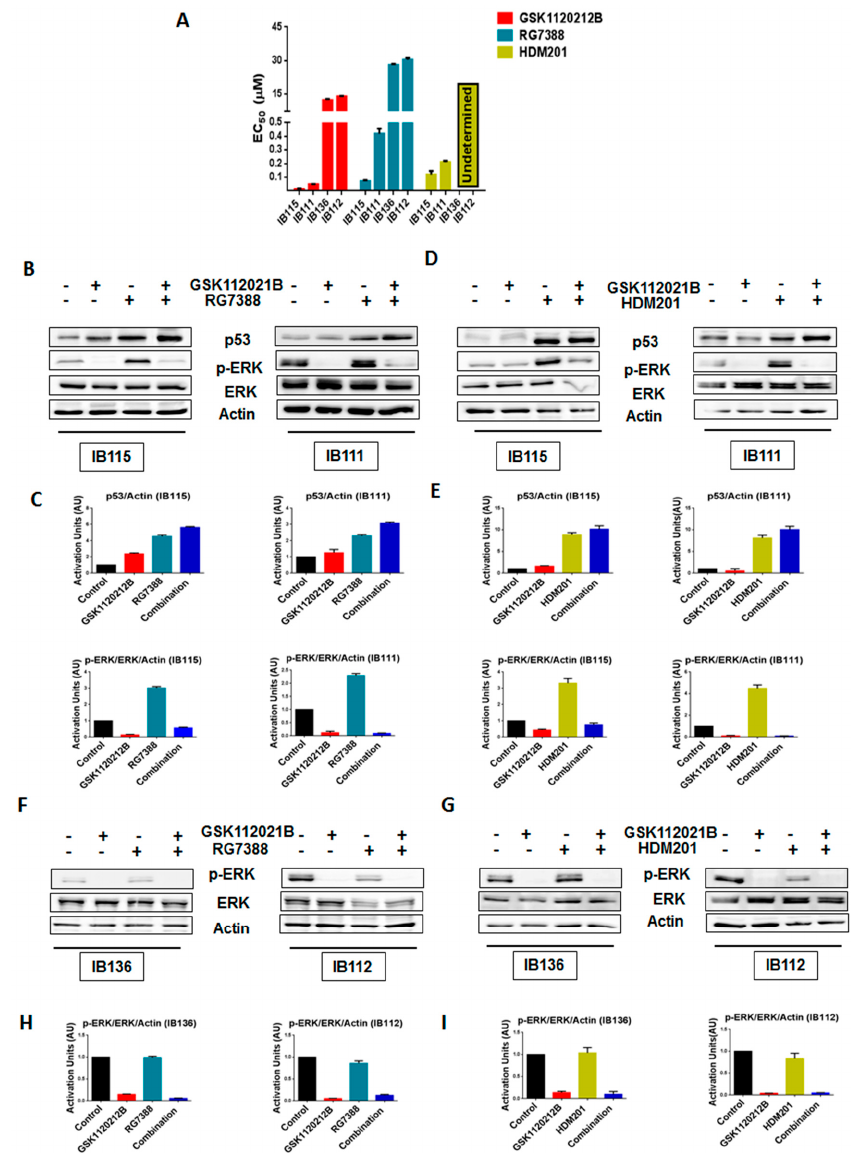
Figure 1. Significant upregulation of p-ERK by MDM2 antagonists is observed in p53 wild-type cells. ( A ) EC 50 values for GSK112021B, RG7388, and HDM201 in p53 wild-type cells (IB115 and IB111) and p53-null cells (IB136 and IB112). ( B ) Representative blots of p53 wild-type cells (IB115 and IB111) treated with GSK112021B and RG7388, alone or in combination, at their EC 50 values and immunoblotted for p53, p-ERK, and ERK. ( C ) Quantification of blots of IB115 and IB111 treated with GSK112021B and RG7388, alone or in combination. ( D ) Representative blots of p53 wild-type cells (IB115 and IB111) treated with GSK112021B and HDM201, alone or in combination, at their EC 50 values and immunoblotted for p53, p-ERK, and ERK. ( E ) Quantification of blots of IB115 and IB111 treated with GSK112021B and HDM201, alone or in combination. ( F ) Representative blots of p53-null cells (IB136 and IB112) treated with GSK112021B and RG7388, alone or in combination, at their EC 50 values and immunoblotted for p-ERK and ERK. ( G ) Quantification of blots of IB136 and IB112 cells treated with GSK112021B and RG7388, alone or in combination. ( H ) Representative blots of p53-null cells (IB136 and IB112) treated with GSK112021B and HDM201, alone or in combination, at their EC 50 values and immunoblotted for p-ERK and ERK. ( I ) Quantification of blots of IB136 and IB112 cells treated with GSK112021B and HDM201, alone or in combination. Immunoblot data shown represent the results of two independent